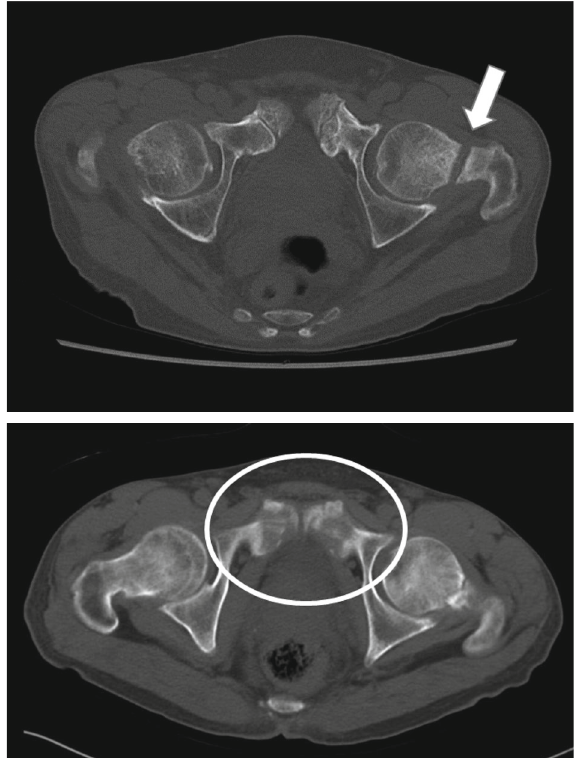
Figure 4: Axial view of the hip joint via computed tomography in 2016 revealing a left femoral neck fracture (white arrow). It revealed an old fracture of the pubic bone (white circle).